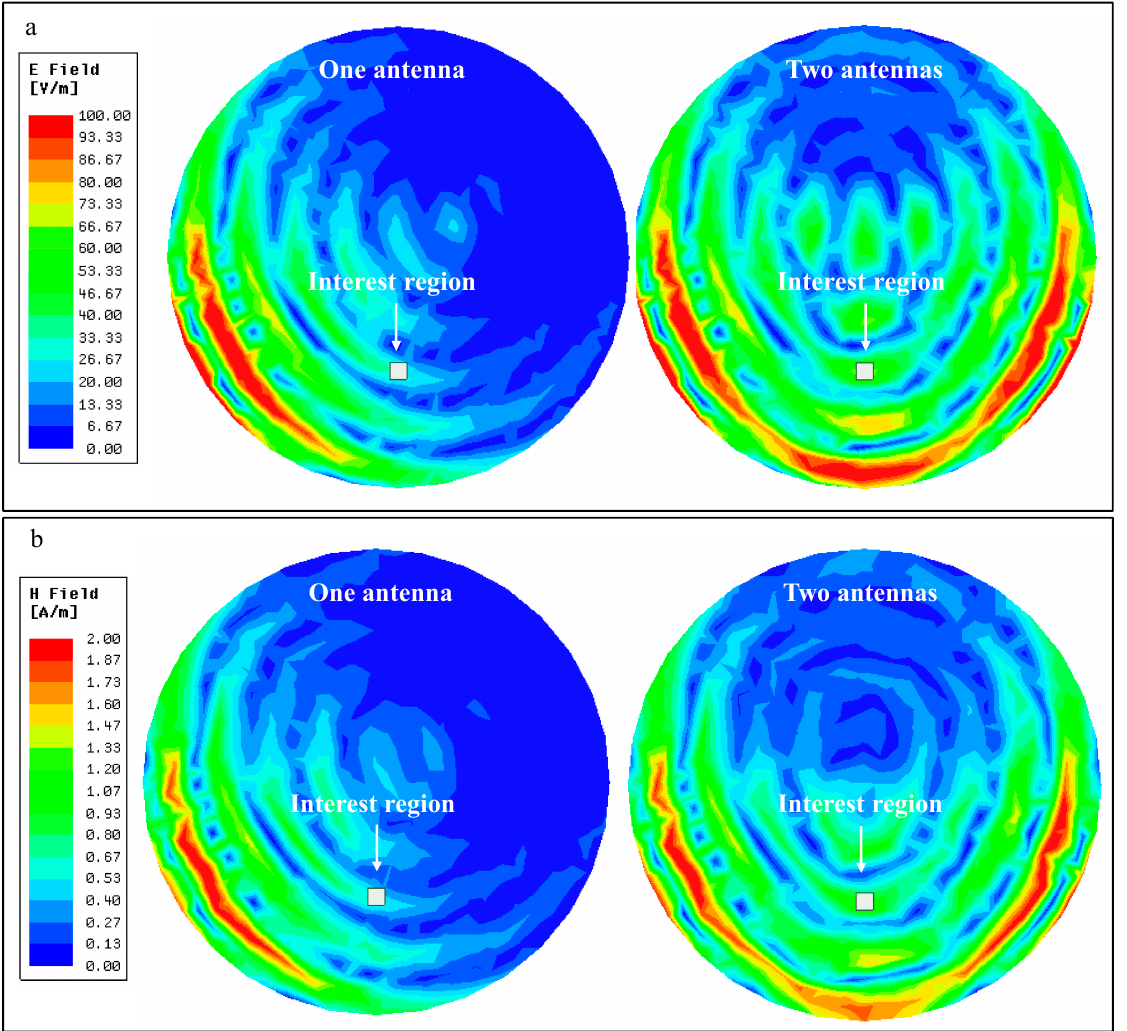
Figure 9. ( a ) Electric field and ( b ) Magnetic field distribution in the human brain phantom for one and two transmitting antennas.